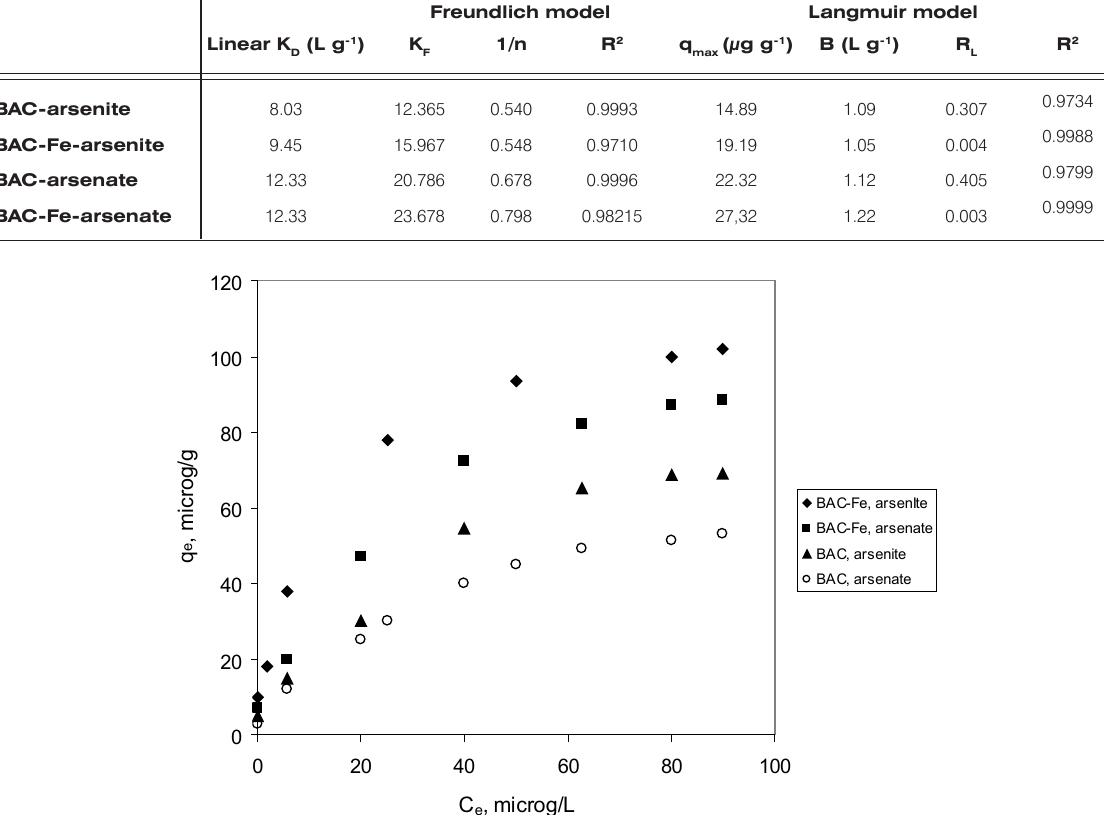
Figure 8. Adsorption isotherms of arsenic and arsenate ions by BAC-Fe and BAC. Experimental conditions: 100 μg L -1 arsenite and arsenate, pH 9.0.